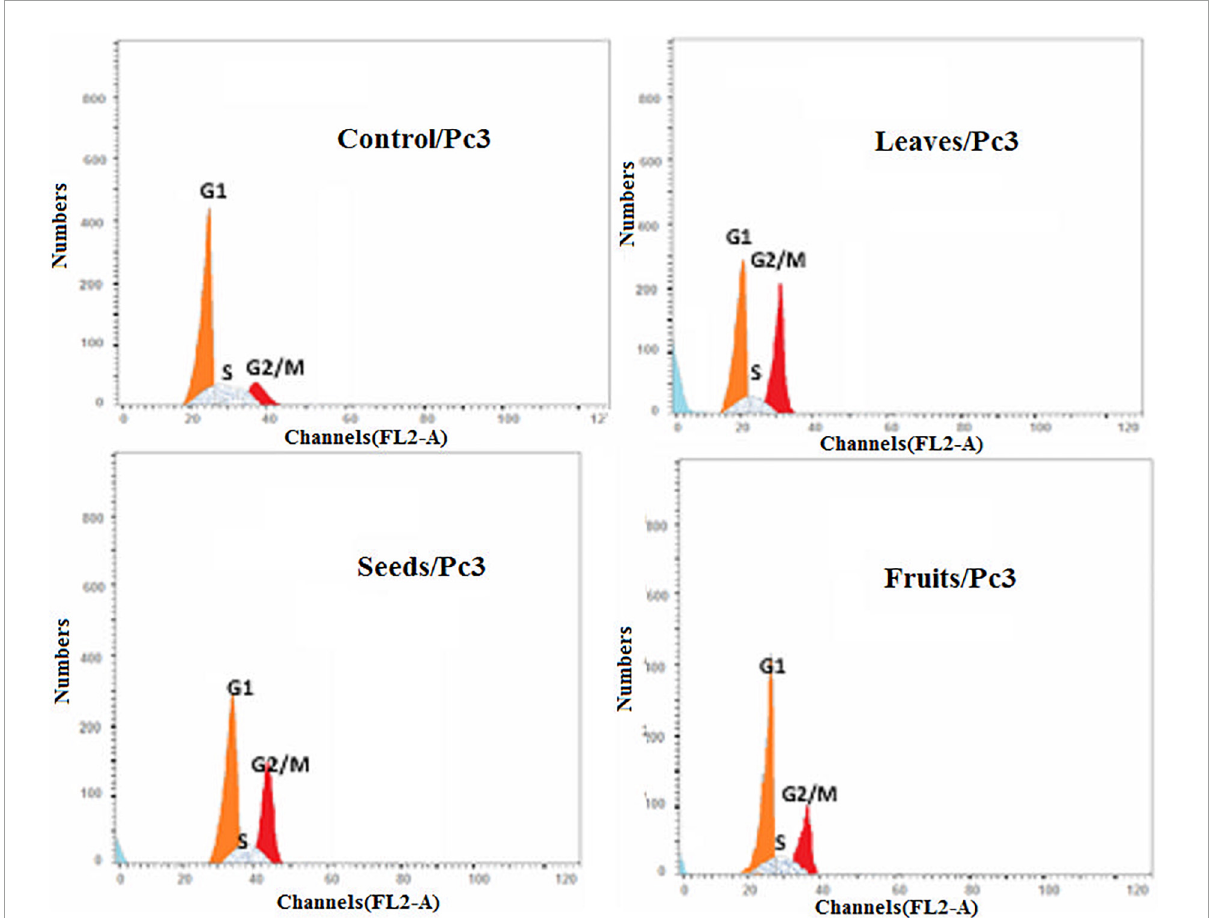
FIGURE11 Cell cycle analysis after treatment of Pc3 cells with leaf, seed, and fruit extracts separately in comparison with